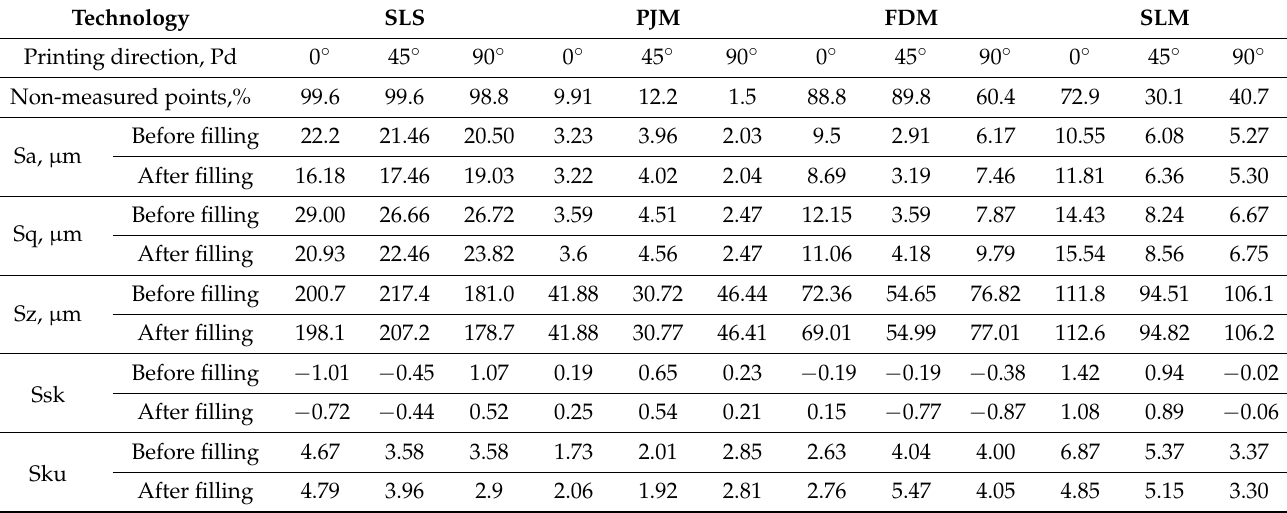
Table 2. Measurement results obtained for the Talysurf CCI optical